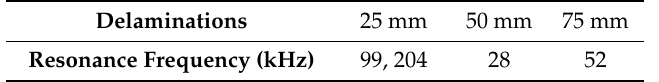
Table 2. Resonance frequencies of different size delaminations in the cross-ply composite plate.